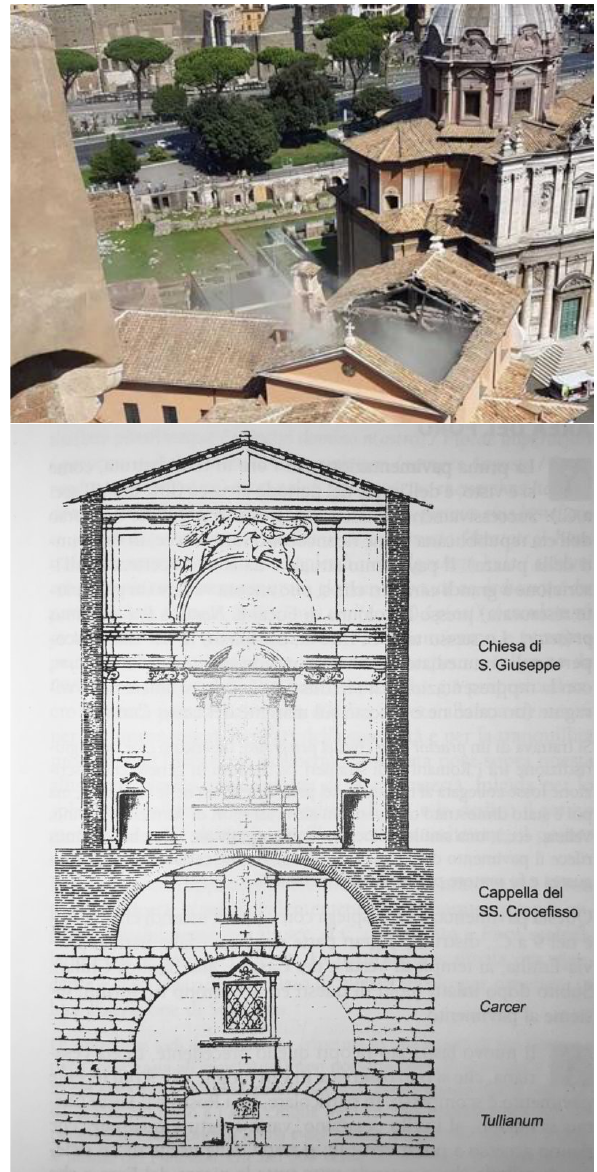
Figure: 11 From top to bottom Image of the church of San Giuseppe ai Falegnami after the collapsing of the roof. Original design drawing of the